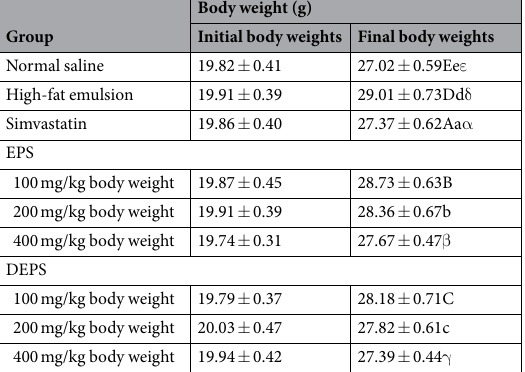
Table 1. Effects of EPS and DEPS on body weights. The values are reported as the means ± SD (n = 10). Bars with different letters are significantly different ( P <